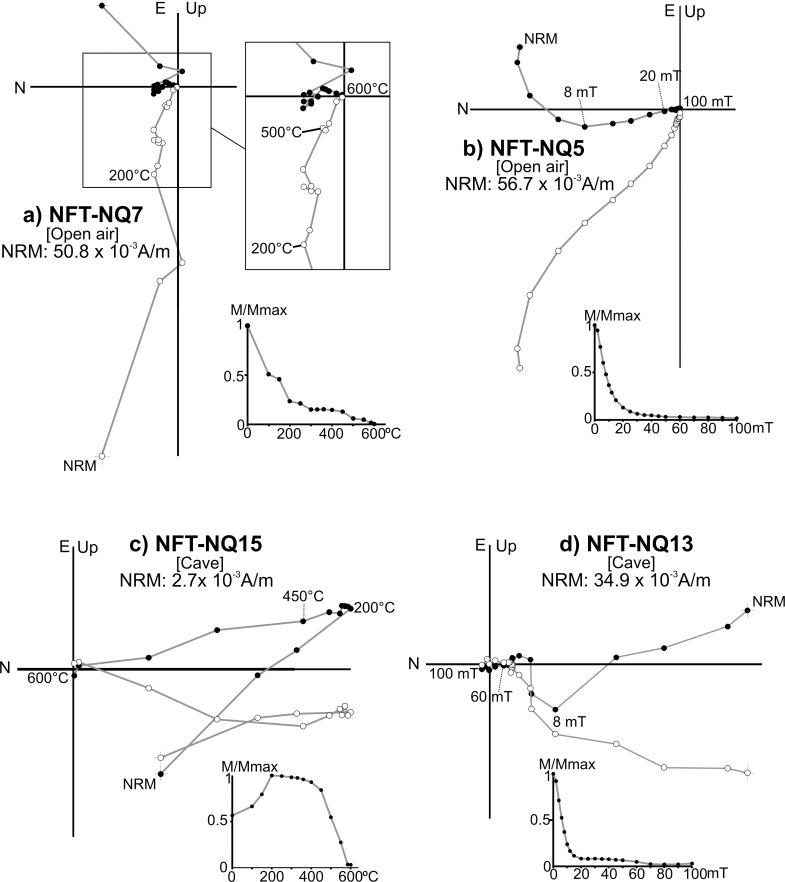
Representative orthogonal plots of NRM thermal and alternating field demagnetizations of samples from unburnt materials.(A-B) Examples from open air; (C-D) examples from cave. This graph shows the structure and direction of the magnetization vector(s) of a sample during the stepwise demagnetization process. Each point represents a demagnetization step. Conventionally, the direction of the vector is defined by two angles: declination (angle respect the North on the horizontal plane) and inclination (angle between the vector and the horizontal plane: downward or upward). Solid (open) circles show projections of vector endpoints onto the horizontal (vertical) plane Sample code, magnetization intensity and normalized NRM intensity decay plots are also shown.